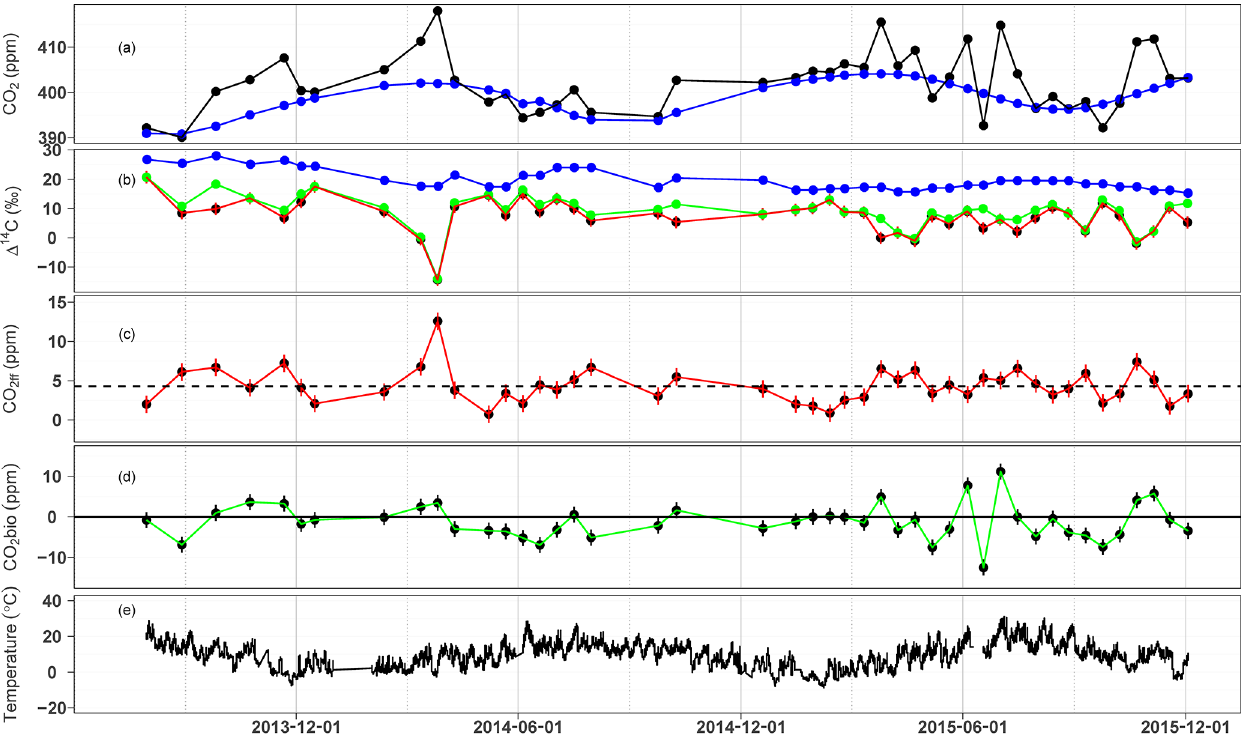
Figure 2. CO 2 mixing ratios (hourly averages) at Beromünster (black) from the sample inlet at 212.5m and from background measurements at Jungfraujoch (blue) filtered using the REBS function for periods when 14 C sampling was conducted (a) , (cid:49) 14 C determined from the biweekly point samplings at the site before (green) and after (red) correction for the intercomparison offset (see Sect. 2.3) and the 14 C contribution from NPPs (see Eq. 5) and from 14-day integrated samplings at Jungfraujoch (blue) (b) , CO 2ff determined during this period applying Eq. (4) with a mean CO 2ff value of 4.3ppm (dashed line) (c) , the biospheric CO 2 determined by simple subtraction of CO 2bg and CO 2ff from the CO 2meas (d) , and the temperature record during this period at the 212.5m height level (e) . Error bars in panels (b) and (c) indicate the mean uncertainty in (cid:49) 14 C measurement ( ± 2.0‰) and calculated CO 2ff ( ± 1.2ppm), averaged for the triplicate samples, while error bars in panel (d) are obtained from error propagation of the components in panels (a) , (b) , and (c) . CO 2 mixing ratios in the top panel are only shown from times matching the radiocarbon sampling at Beromünster